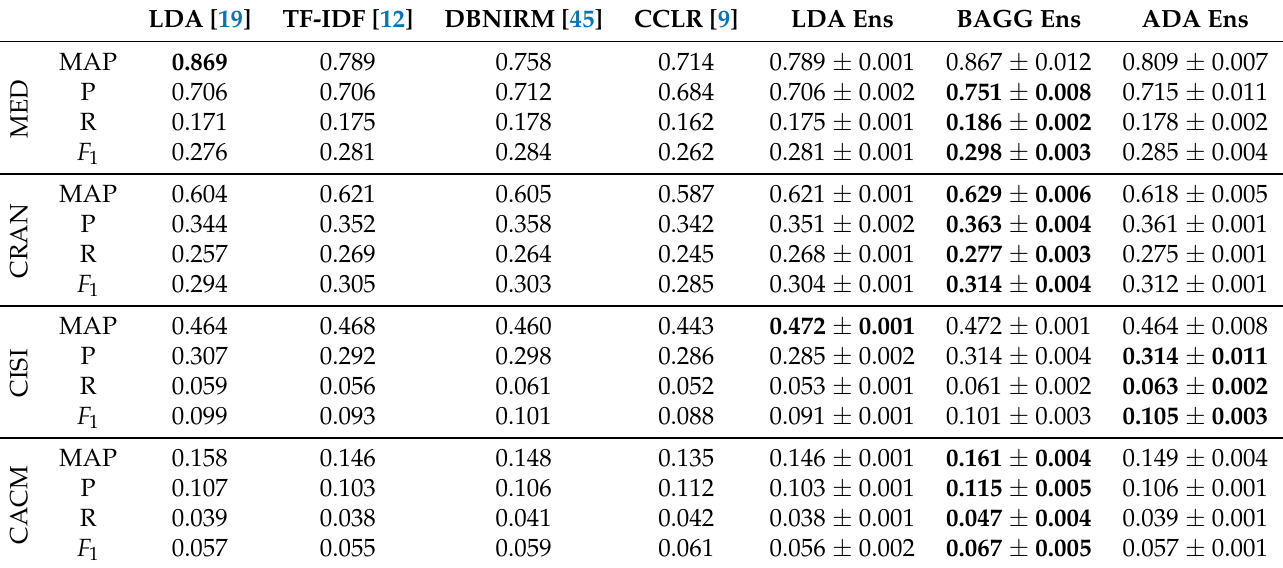
Table 3. Results reported using @5